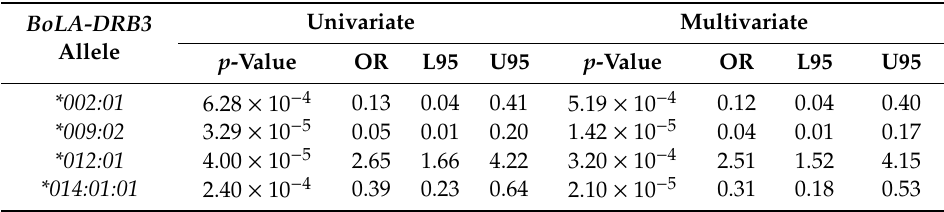
Table 6. Logistic regression analysis based association study of BoLA-DRB3 alleles in low PVL and high PVL cows after adjustment of age.